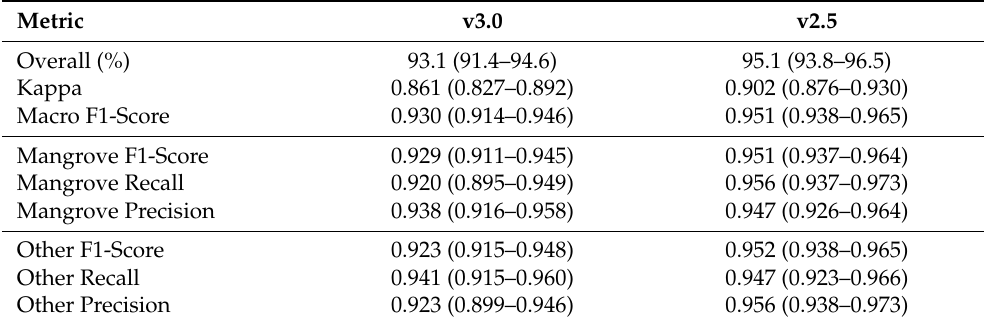
Table 7. Results of the GMW v3.0 2010 accuracy assessment compared to those of v2.5, where the 95th confidence intervals are given in brackets.